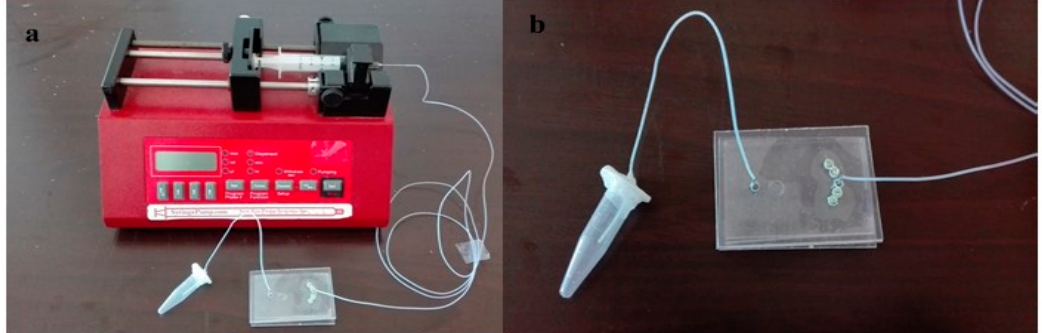
Figure 3. Microfluidic apparatus: ( a ) Microfluidic device showing the pump, chip and collecting tube arrangement; ( b ) chip with collecting tube.